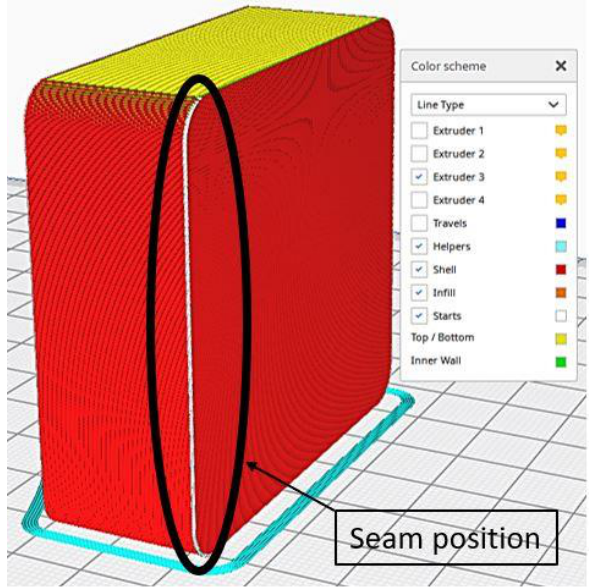
Figure 4. Seam positioning.